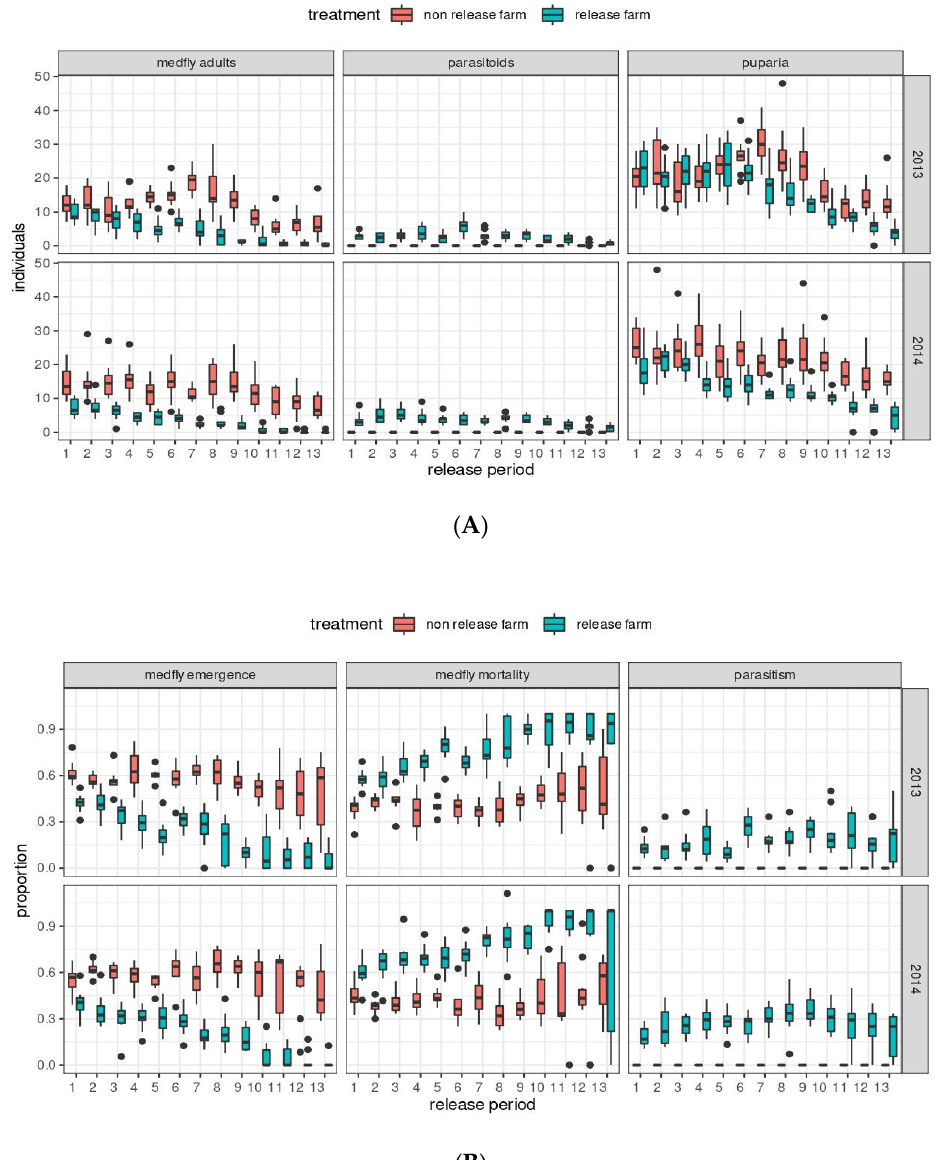
Figure 2. Temporal variations in the numbers of emerged medfly ( Ceratitis capitata ) and parasitoid ( Diachasmimorpha longicaudata ) adults, and recovered medfly puparia ( A ), and proportions of medfly emergence, parasitism, and medfly mortality ( B ) by release period (between 26 December 2012 and 23 May 2013, and between 26 December 2013 and 23 May 2014) and farm condition (non-parasitoid release farm (CF) and parasitoid ( D. longicaudata ) release farm (TF)). The boxes signify the interquartile range and include the median; the whiskers characterize data 1.5 times the interquartile range, and the black points are